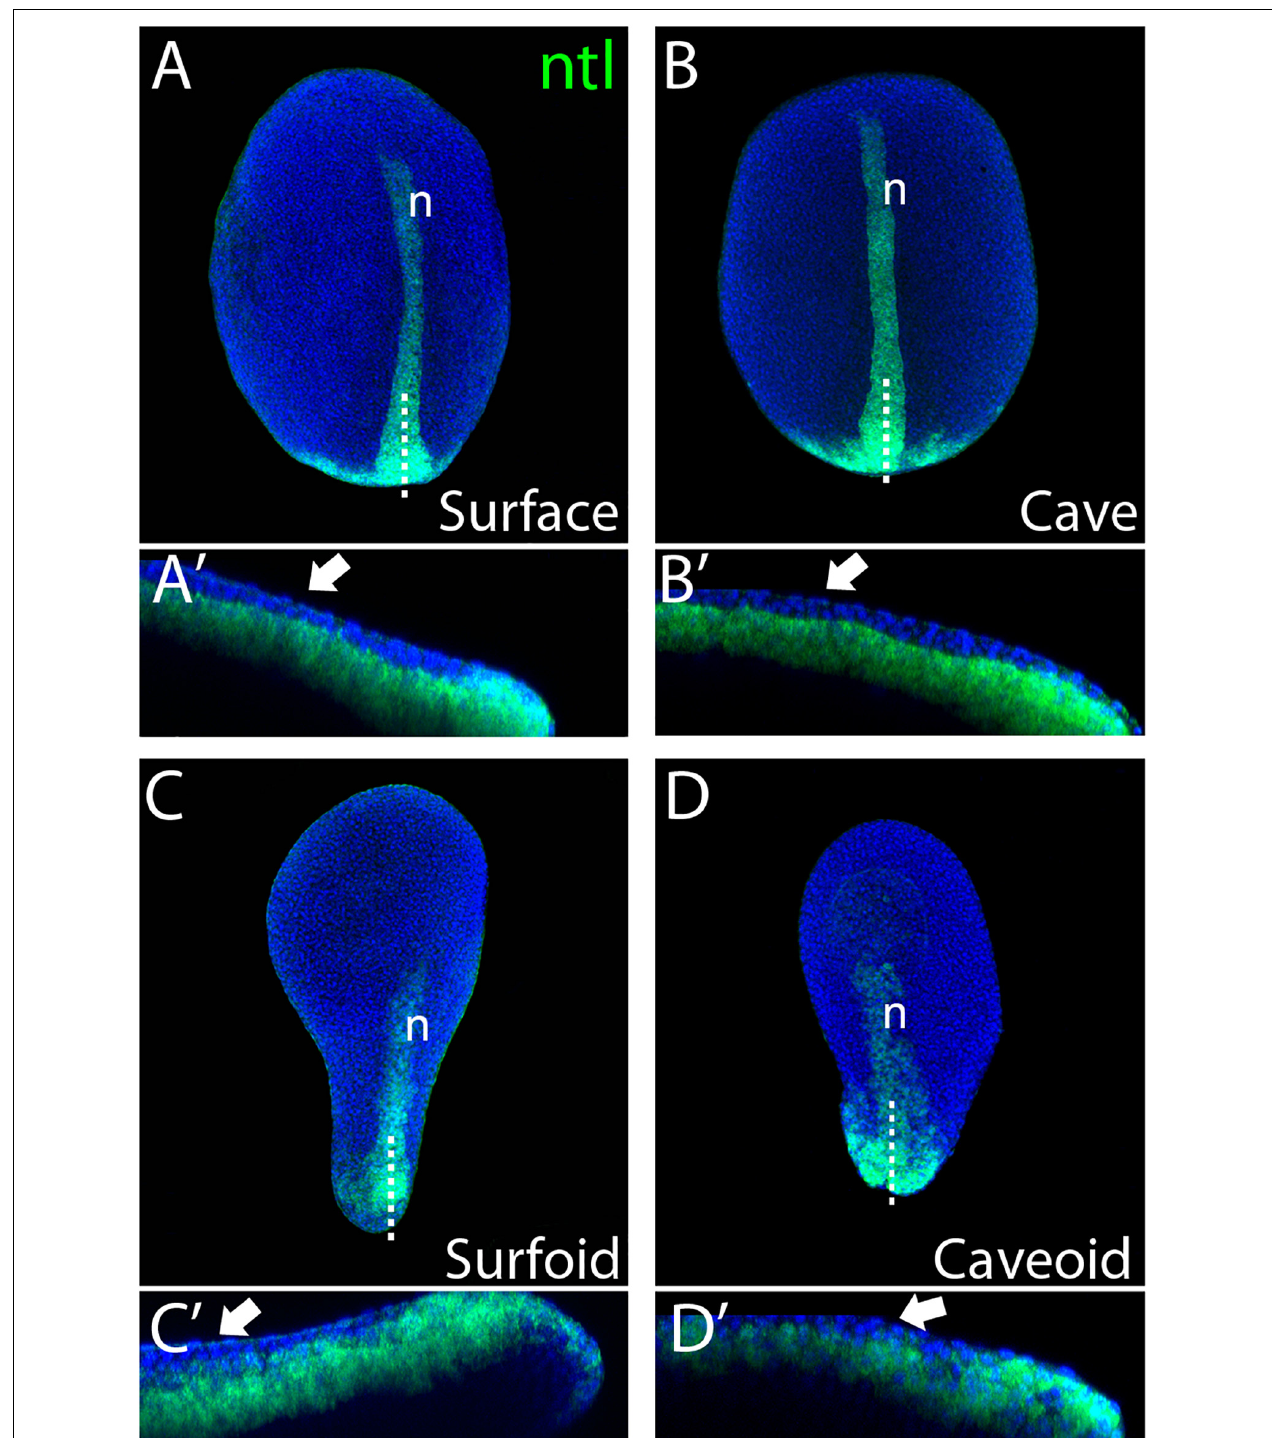
FIGURE 2 | Internalization of mesoderm in Astyanax pescoids. Expression of ntl in intact surface and cavefish embryos at 10 hpf [ (A,B) , respectively], and in surfoid and caveoid after 7 hpc [ (C,D) , respectively]. Embryos are oriented in dorsal views, anterior to the top. For each panel, bottom images (A’–D’) are confocal reconstructions at the indicated level (dotted lines), anterior to the left and dorsal to the top. The white arrows indicate ectodermal cells overlying ntl -expressing mesodermal cells and n indicates the notochord.